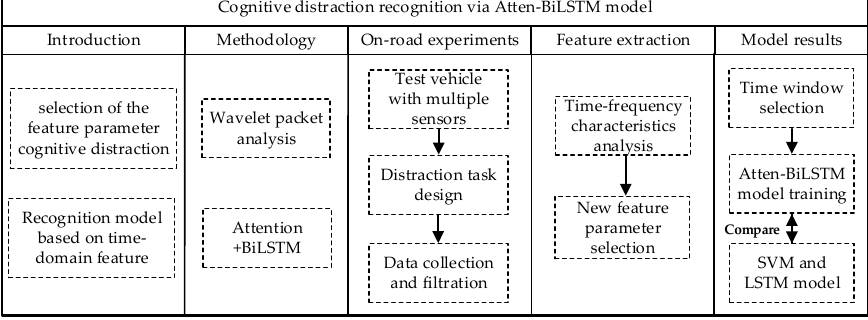
Figure 1. Cognitive distraction recognition framework.